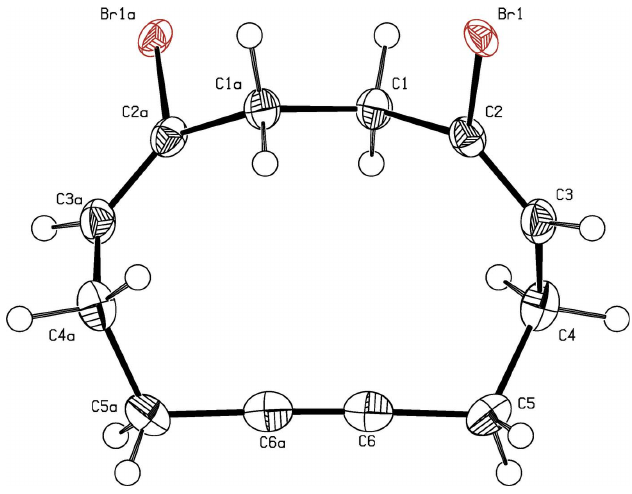
Figure 1 View of the title compound. Displacement ellipsoids are drawn at the 50% probability level. Atoms with the suffix a are generated by the symmetry operation (cid:3) x , y , (cid:3) z + 1